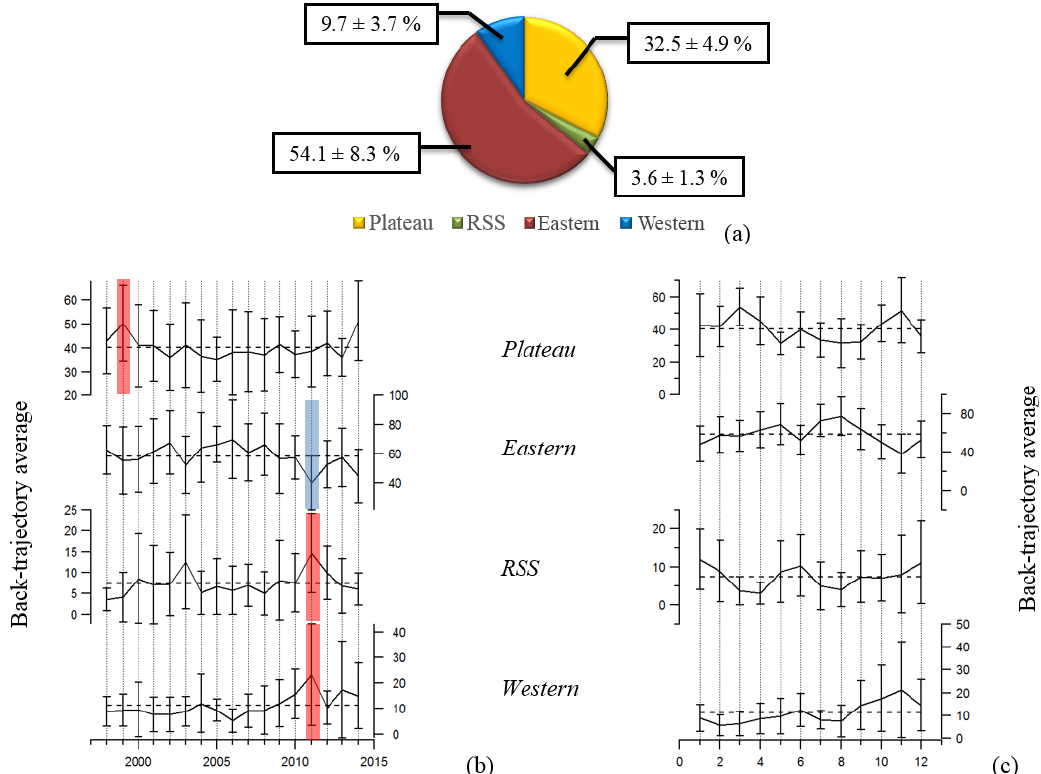
Figure 9. Results of daily back-trajectory calculations over the period 1998–2014 with (i) the percentage (%) of the sum of back trajectories passing over each defined region: (i) the eastern sector (0–66 ◦ S, 0–180 ◦ E), (ii) the plateau (66–90 ◦ S, 0–180 ◦ E), (iii) the Ross Sea sector (0–75 ◦ S, 180–240 ◦ E), and finally (iv) the western sector (0–75 ◦ S, 180–240 ◦ E) and (50–90 ◦ S, 240–360 ◦ E) (see Sect. 2.3), and with (ii) averages at the annual scale (b) and at the mean seasonal scale (c) . In (b) and (c) ) horizontal dashed lines correspond to the mean value and vertical solid lines to standard deviations. Remarkable years, i.e. associated with values deviating by at least 2 standard deviations from the climatological mean value, are highlighted with red shading (positive anomalies) or blue shading (negative anomalies).